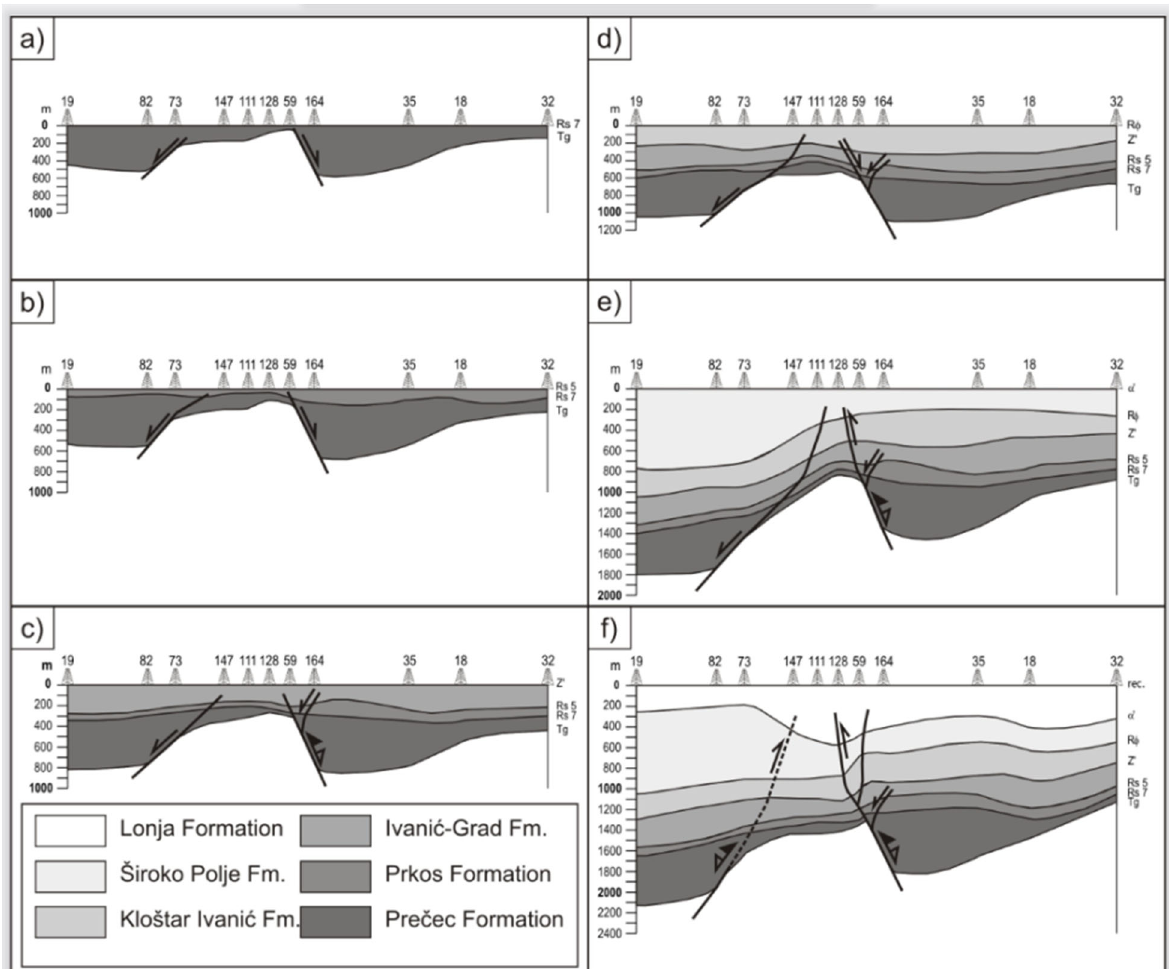
Figure 8. Palinspastic analysis of the Kloštar structure in the Sava Depression. The thickness and shape of the oldest, Pre č ec Formation (upper part of the Early Miocene and Middle Miocene), was dominantly influenced by a paleorelief ( a ). Relief still influenced the deposition and thicknesses of the overlying Prkos and Ivani ć‐ Grad Fms. (lower part of the Late Miocene) ( b , c ). The overlying Kloštar Ivani ć Fm. was deposited with less tectonic influence ( d ). The two youngest formations (Široko Polje and Lonja Fm.) (upper part of the Late Miocene) are much thicker ( e ), and the main depositional area had shifted to the SW. Normal faulting is no more dominant, and the main fault (on the NE side of the large uplifted central structure) is reactivated as a reverse fault [106].